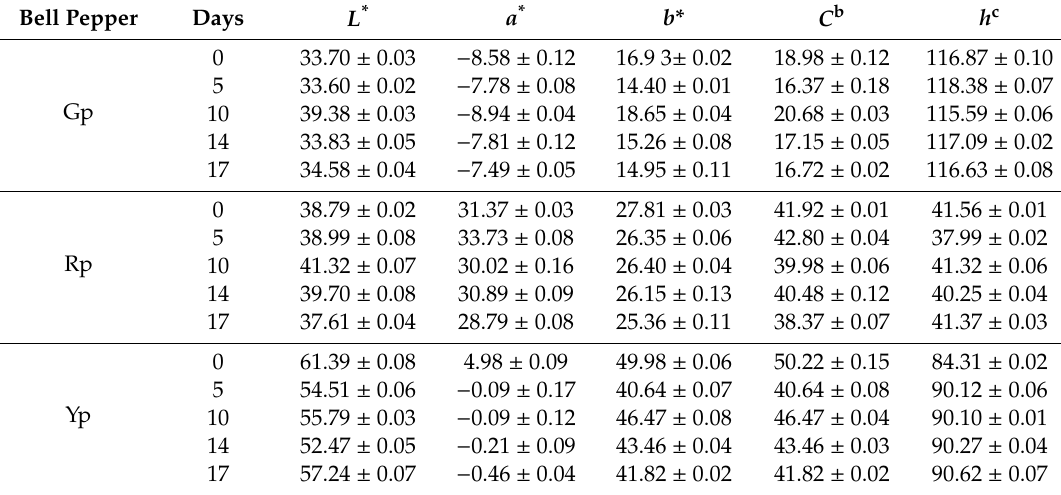
Table 1. Colorimetric parameters of bell peppers a